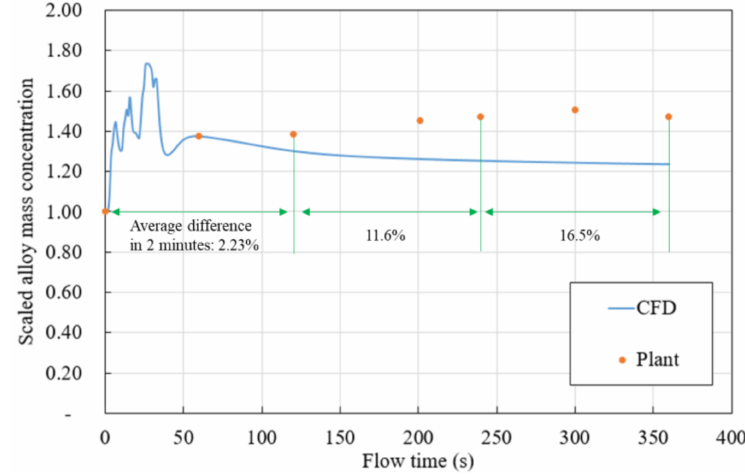
Figure 7. Scaled alloy mass concentration comparison (plant measurement–CFD).